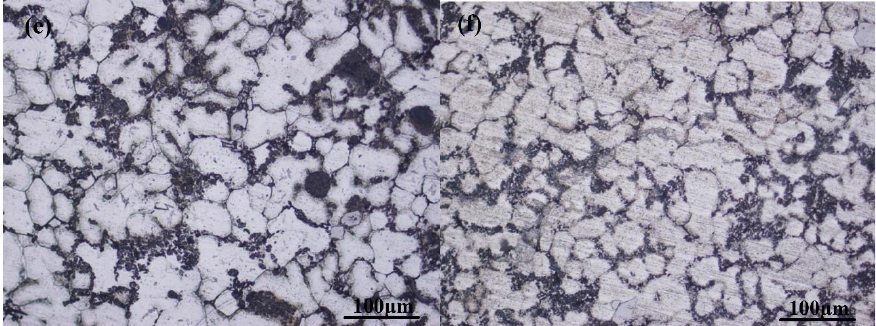
Figure 12. OM microstructure of rheoformed 2024 aluminum matrix composite component reinforced by different volume fraction of Al 2 O 3 nanoparticles at 620 °C and for 25 min stirring time ( a ) 2024 matrix; ( b ) 1%; ( c ) 3%; ( d ) 5%; ( e ) 7%; ( f ) 10%.